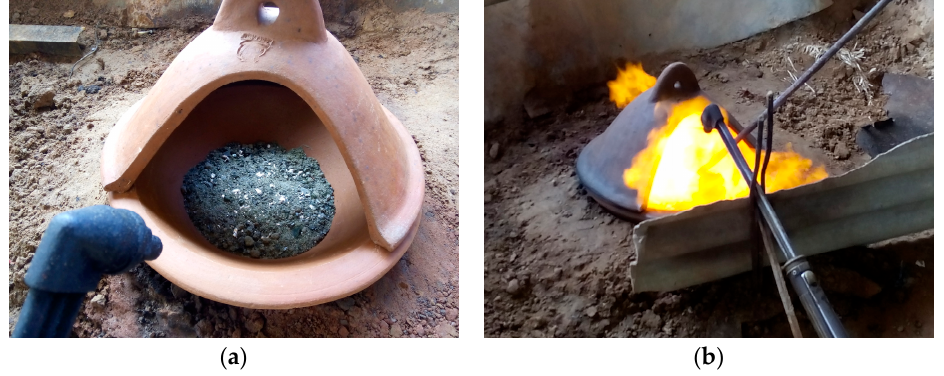
Figure 5. Final extraction process using silver as a collector metal before ( a ) and during smelting ( b ).